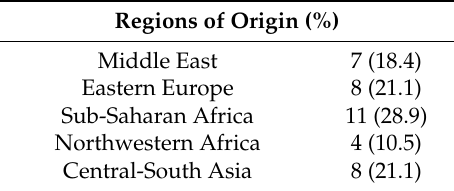
Table 2. The regions of the origin of persons with a rejected application ( n = 38). Regions of Origin